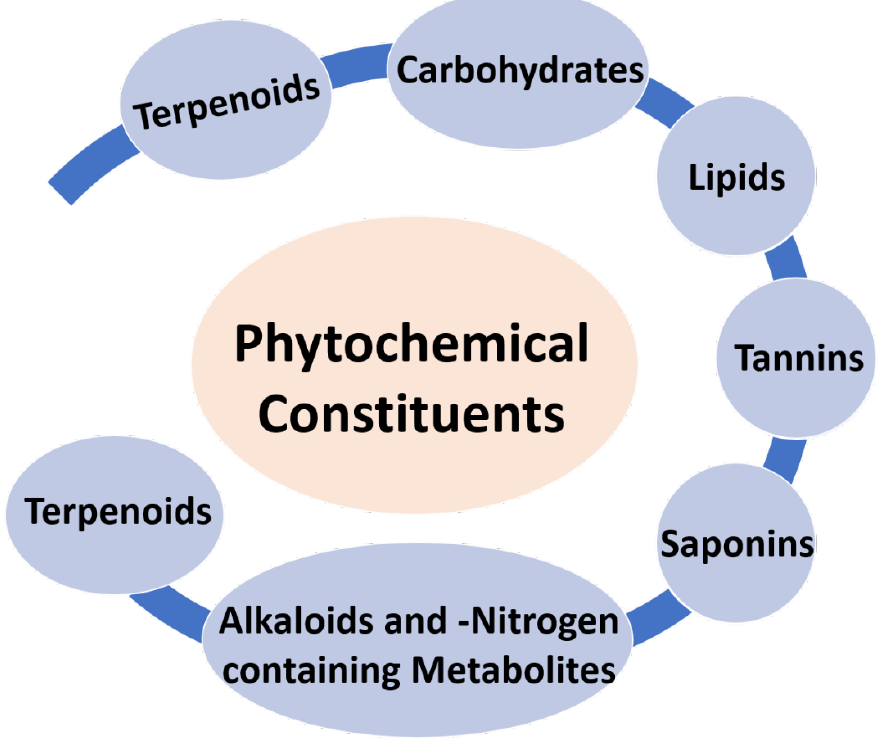
Figure 1. A typical illustration of the presence of phytochemicals in plants and the right key choice for electrochemical studies.